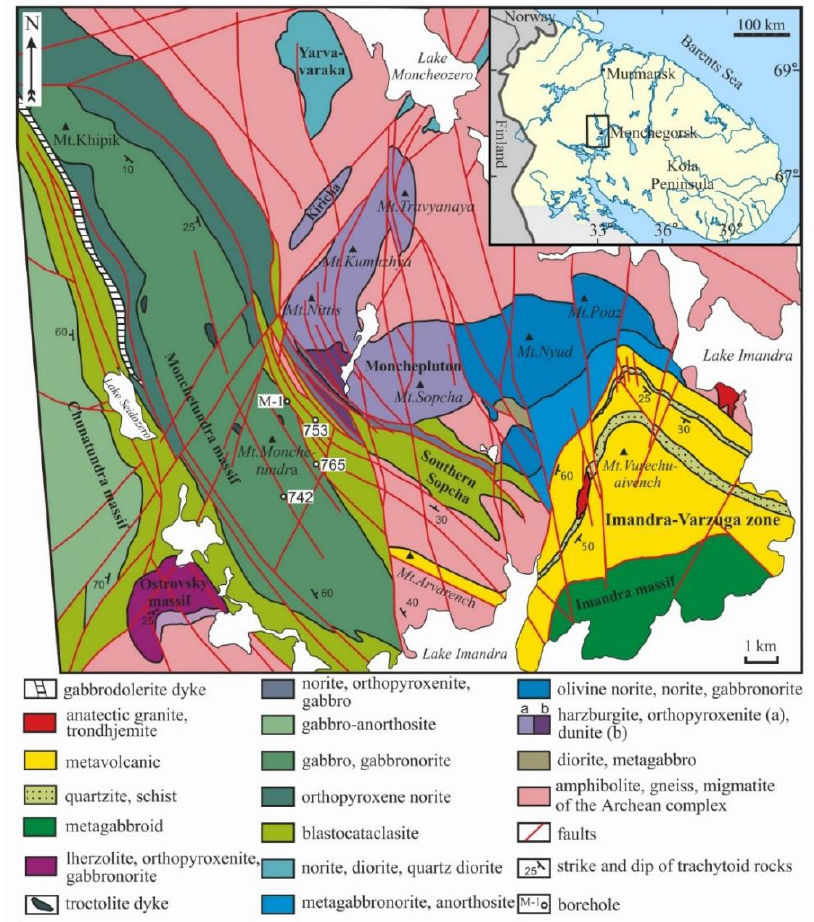
Figure 1. Geological map of the Monchegorsk ore district, modified after